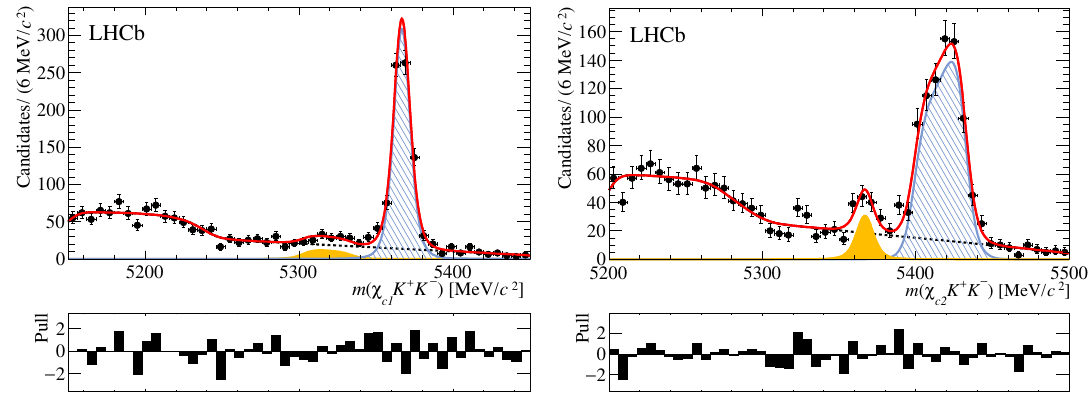
+ K (cid:0) (cid:12)t and c 1 K